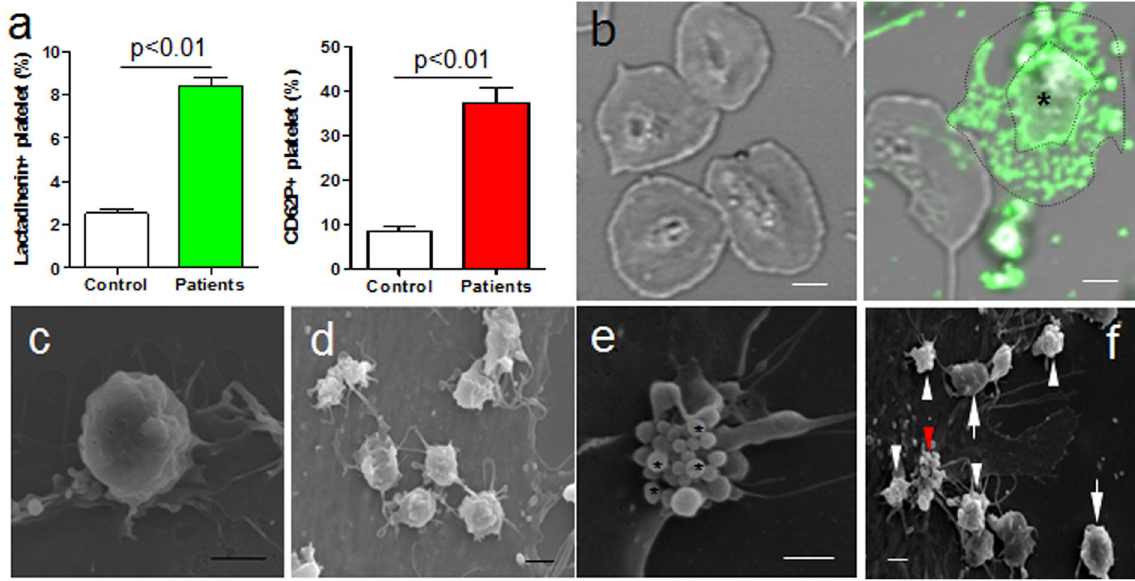
Figure 1. Activation of platelets in sepsis. ( a ) Flow cytometry analysis of PS and CD62P on platelets from healthy controls (n = 27) and patients (n = 27). Data represents mean ± SD. Morphology of platelets from patients (n = 15) were measured by confocal and electron microscopy and some typical forms were presented ( b – f ). ( b ) Confocal images showed PS expression on platelets of healthy subjects (left panel) and patients (right panel) stained with Alexa 488 lactadherin. In the patients’ sample, microparticles from one platelet ( * ) had formed at the margin area located between the distinct outlines. Scanning microscopy showed ( c ) inactivated rounding platelets without pseudopods; ( d ) activated platelets with spreading pseudopods; ( e ) platelet apoptosis with vesicle formation ( * ); ( f ) quiescent (arrow), activated (white arrowhead) and apoptotic (red arrowhead) platelets in patients. Bars represent 2 μ m ( b – f